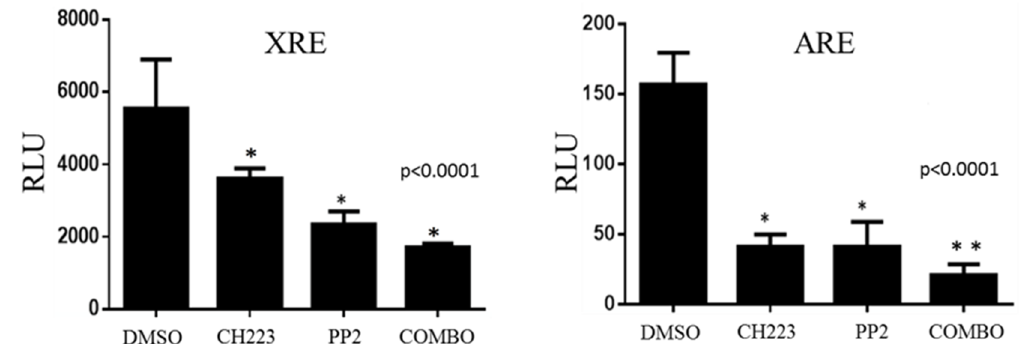
Fig 2. Simultaneous inhibition of AhR and Src significantly decreaseAR and AhR promoter activity. C4-2 cells were transfected with an XRE reporter plasmid& ARE reporter plasmid, as well as with positive and negative control reporter plasmidsusing attractene. Followingtransfection, treatments were added to each appropriate plate. A dual luciferaseassay was performed and promoteractivity values are expressedas arbitrary florescenceunits (AFU). Each bar representsmean ± SEM (n = 3) and were analyzedby student t-test. ( * ) denotesstatistically significantdifferences ( * P <